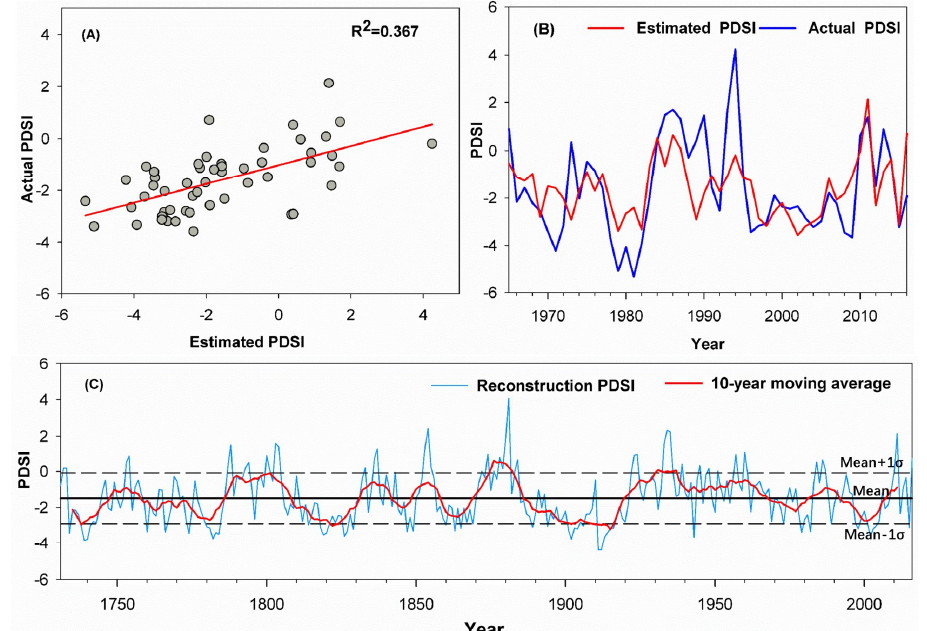
Figure 5. ( A ) Correlation of actual and estimated June PDSI during the period of 1965 – 2016; ( B ) Comparison of actual and estimated June PDSI 1965–2016. ( C ) Tree‐ring reconstructed June PDSI plotted annually (blue line) 1731–2016, along with a smoothed 10‐year moving average (red line). Table 2. Ten driest and wettest years for reconstructed Palmer Drought Severity Index (PDSI). Driest Rank